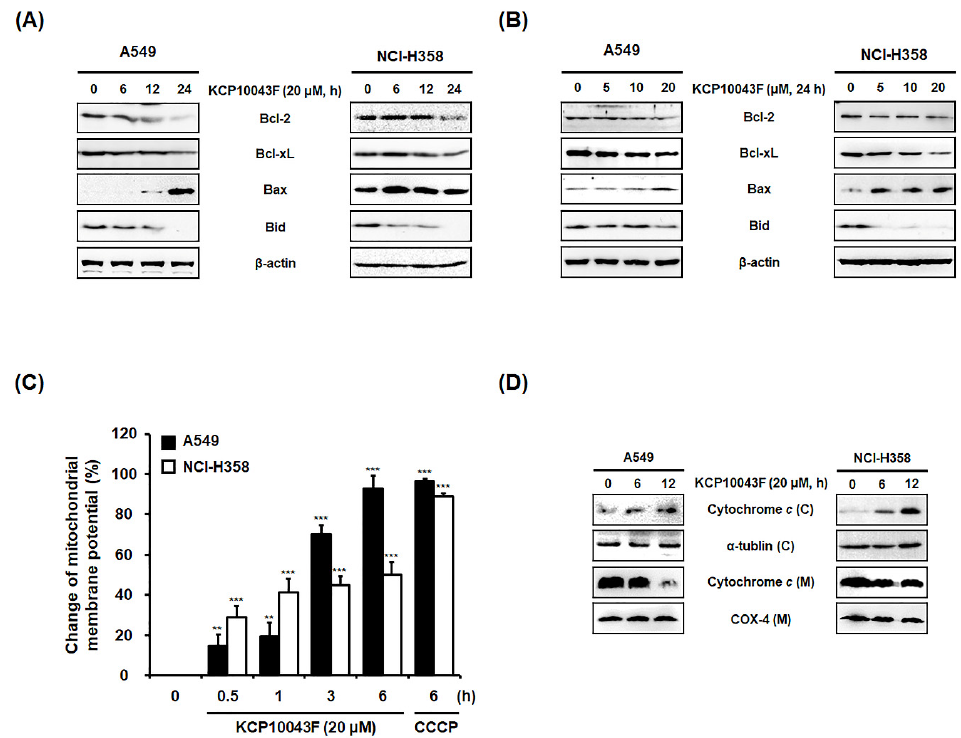
Figure 3. Regulation of mitochondria-related proteins by KCP10043F in A549 and NCI-H358 cells. ( A ) Cells were treated with 20 µ M KCP10043F for the indicated times (6, 12, or 24 h) and (B)